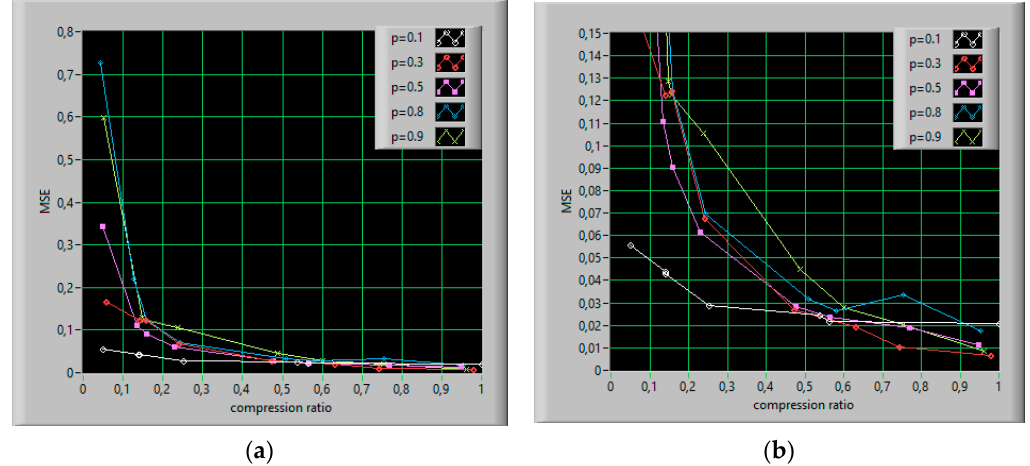
Figure 12. Mean square error (MSE) versus compression ratio for different values of the ones probability p , ( a ) in a full range, ( b ) for a threshold of MSE = 0.15.